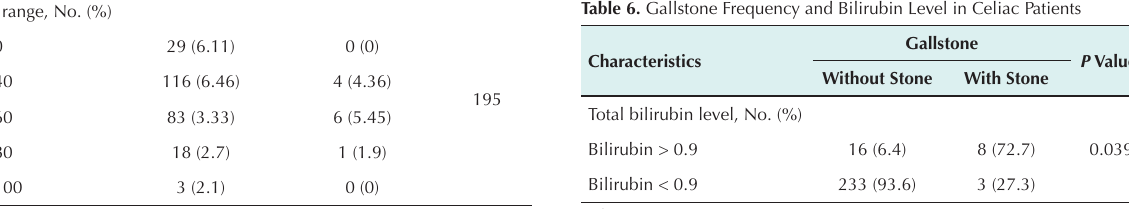
Table 3. Gallstone Frequency and Age of Celiac Patients Characteristics